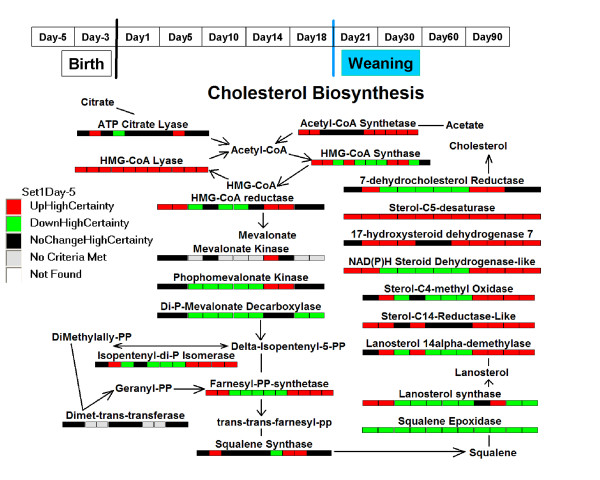
An example of PSCP files in which multiple microarray datasets were analyzed simultaneously. The PSCP file for "Cholesterol Synthesis" pathway analyzed for the data from 11 different microarray datasets or CRI files representing a time course experiment (see Additional file 11 for description of material and data preparation). Pooled hepatic mRNA were isolated from female wild type mice sacrificed at different time points during fetal and post-natal development indicated. The time point at 9 day before birth was used as the reference level of mRNA. "Day-5" and "Day-3" indicates 5 days or 3 day prior to birth, respectively.